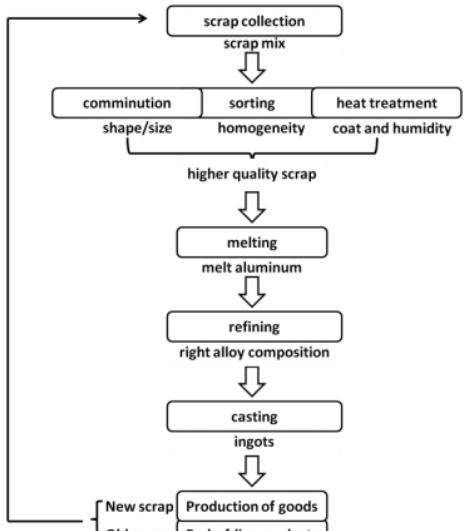
Figure 2. Flow chart of secondary Al refining operations for the production of foundry